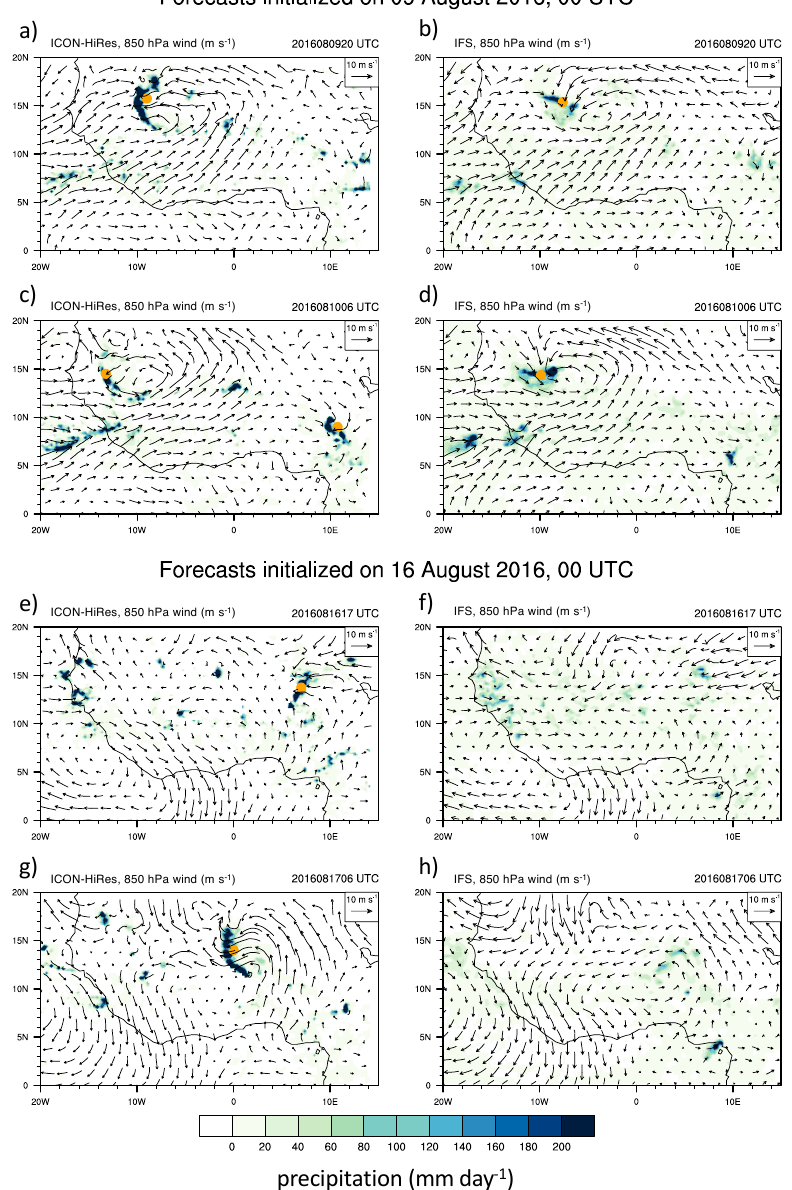
Figure 5. Surface precipitation and large-scale wind fields at 850 hPa from the forecasts initialized on 9 August 2016 ( a – d ) and 16 August 2016, 00 UTC ( e – h ). Data are shown for different forecast lead times: 20 ( a , b ) and 30 ( c , d ) hours for 9 August 2016; 17 ( e , f ) and 30 ( g , h ) hours for 16 August 2016 and two models: ICON-HiRes ( a , c , e , g ) and IFS ( b , d , f , g ). The wind fields represent the instantaneous values at the respective forecast lead time, and precipitation fields represent accumulations during the preceding forecast hour. Filled circles denote objectively-identified mesoscale precipitation features (cf. Section 2.2, γ p ,2 D = 70 mm day − 1 ). All data are coarse-grained to 0.25 ◦ × 0.25 ◦